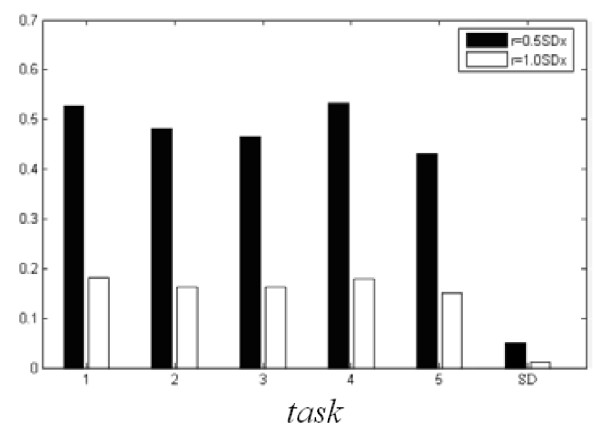
Statistic average histogram of the approximate entropy of subject 1 when r = 0.5SDx and r = 1.0SDx.